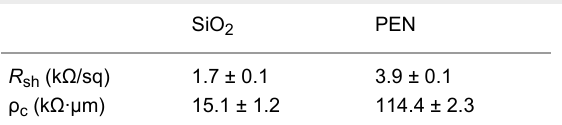
Table 1: Comparison between the sheet resistance and the metal/ graphene specific contact resistance of graphene deposited on SiO 2 and on